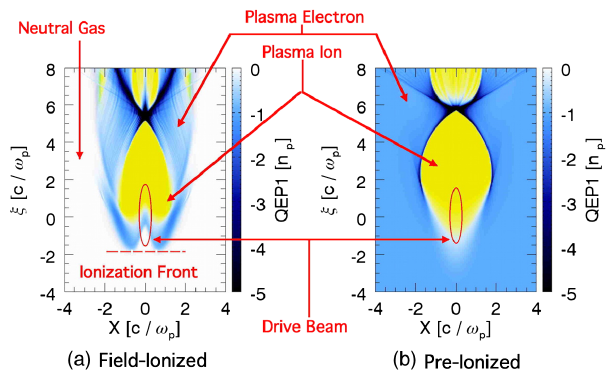
FIG. 1. Snapshot of the plasma electron density from the wake exited by an electron beam in (a) a field-ionized lithium plasma (the plasma ions are shown in yellow and the area in white is filled by the neutral atoms that are not ionized) and (b) a preformed plasma. The plots are a 2D cross section at the center of the 3D simulation box. The drive beam (shown as the red contour) is moving